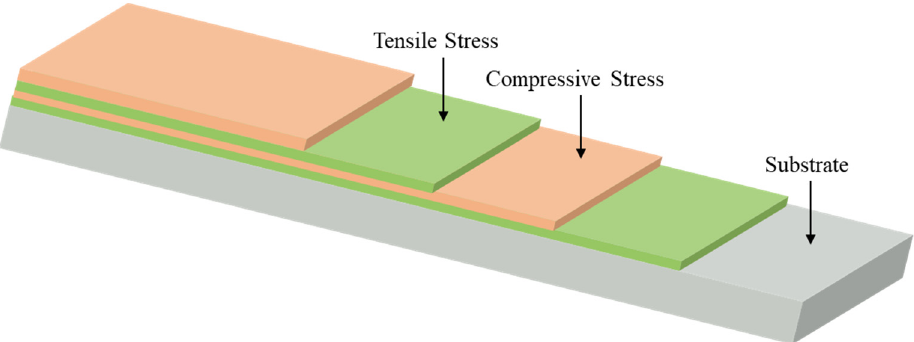
Figure 1. Schematic diagram of the stress-matching design principle.